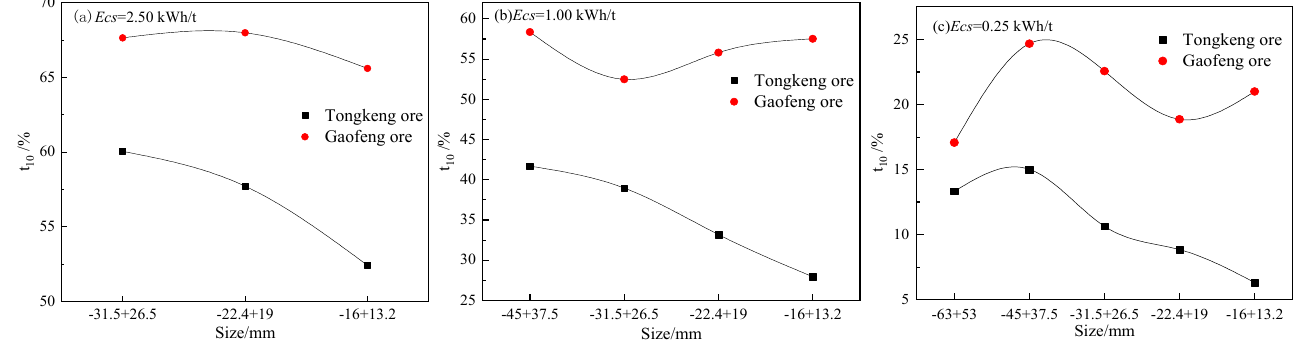
Figure 5. The t 10 change curve of two ores at different specific crushing energies. It can be seen from Figure 5 that under the same specific crushing energy, the t 10 value of Tongkeng ore of any particle size is less than that of Gaofeng ore. That is, the breakage resistance of Tongkeng ore is greater than that of Gaofeng ore, and Gaofeng ore is easier to be crushed. At the same time, the effect of feed particle size on the crushing effect is related to the specific crushing energy and ore type. Generally speaking, the t 10 value of Tongkeng ore decreases with the decrease in feed particle size, while the effect of feed particle size on Gaofeng ore is more